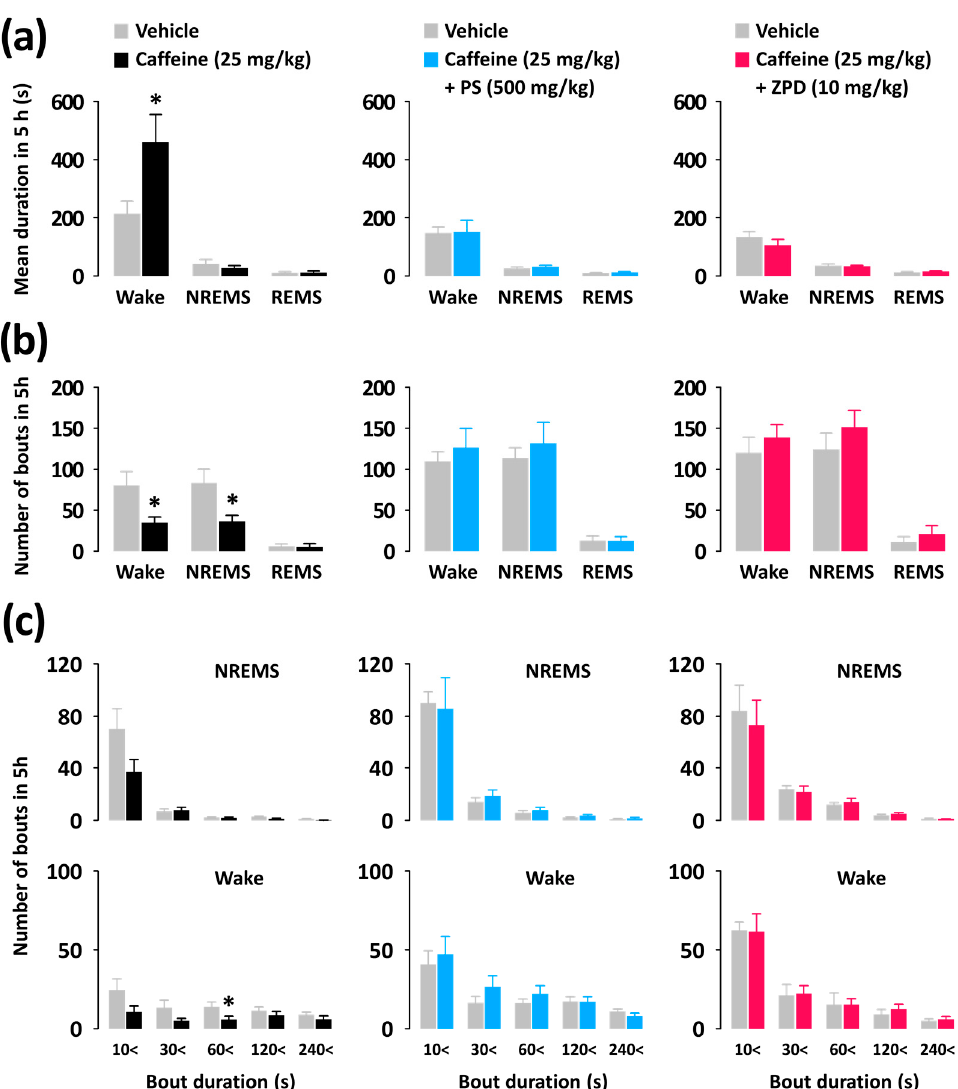
Figure 4. Characteristics of sleep-wake episodes in C57BL/6N mice during the 5 h period after administration of caffeine alone and co-administration of PS or ZPD with caffeine. ( a ) Changes in the mean duration of Wake, NREMS, and REMS bouts. ( b ) Changes in the total number of Wake, NREMS, and REMS bouts. ( c ) Changes in the numbers of NREMS and Wake bouts for different ranges of duration. Grey bars indicate the baseline day (vehicle). Each value represents the mean ± standard error of the mean of each group (n = 7–8). * p < 0.05, significantly different from the vehicle control (unpaired Student’s t -test). NREMS, non-rapid eye movement sleep; PS, a standardized phlorotannin supplement; REMS, rapid eye movement sleep; Wake, wakefulness; ZPD, zolpidem.